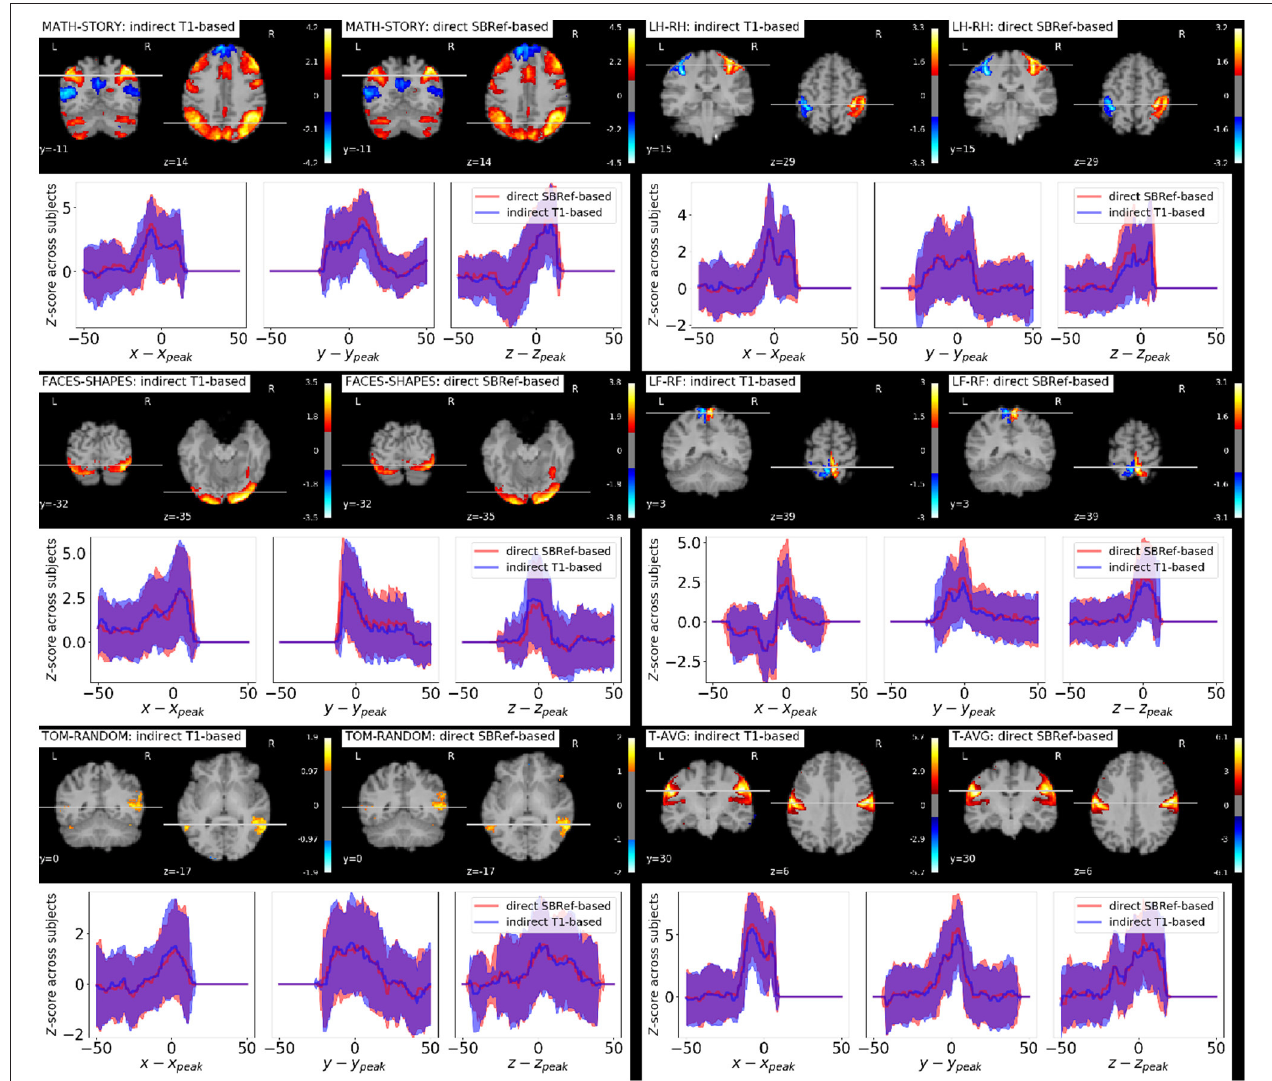
FIGURE 6 | Qualitative comparison of pipelines via GLM results. For each task contrast, and for each registration pipeline (indicated in the legends), we plot across-subject mean activation maps of Z -scores. We also plot corresponding curves showing the variability of subject-specific activation Z -scores at brain locations within a 50 mm radius of x , y , and z coordinates of the group activation peaks. The figure reveals that the activation peaks across the different subjects are highly variable both in amplitude and spatial location. We see that our proposed direct EPI-based registration scheme leads to slightly higher activation